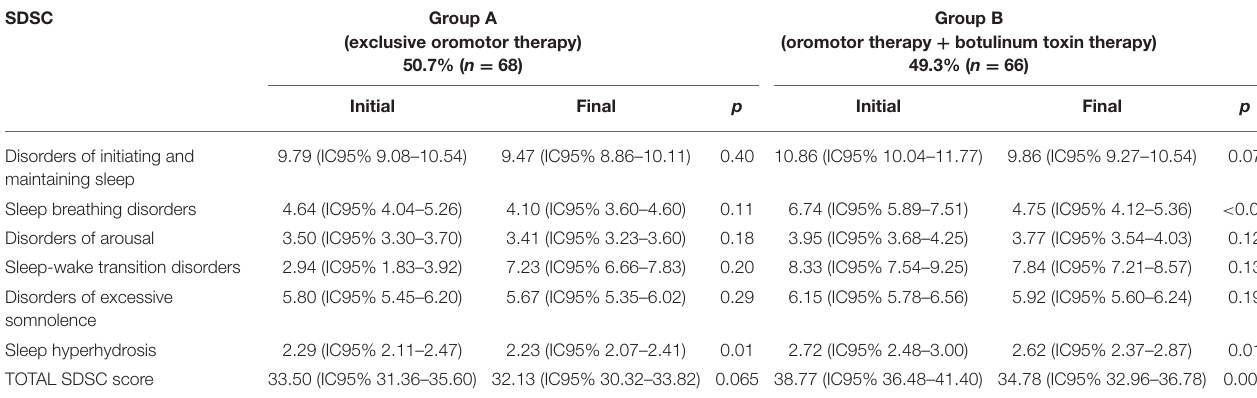
TABLE 3 | SDSC means and confidence intervals (initial and final by treatment